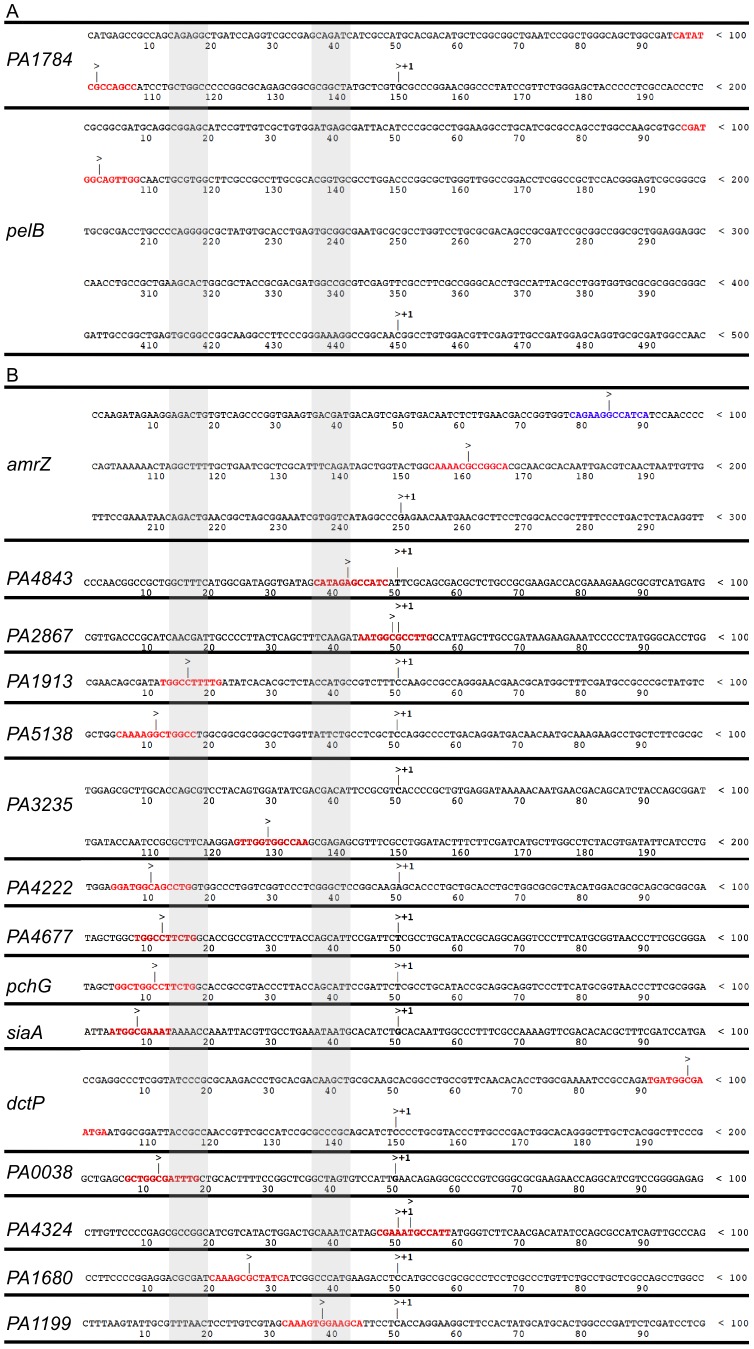
AmrZ binds near the start of transcription of repressed genes, but not activated genes.Promoter alignment of genes bound by AmrZ (≥4 fold enrichment) and A activated or B repressed (≥4 fold regulation). Alignment of repressed genes implies a common mechanism for AmrZ-mediated repression. Transcriptional start sites were called from RNA-Seq analysis. Sequences of AmrZ-repressed promoters are aligned at their transcriptional start site (+1). The putative AmrZ binding site is indicated by red text. Blue text in the amrZ promoter indicates a second AmrZ binding site, previously annotated AmrZ2. The promoter regions are indicated by grey shading.